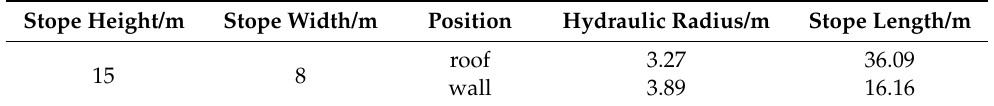
Table 5. Calculation statistics of stope